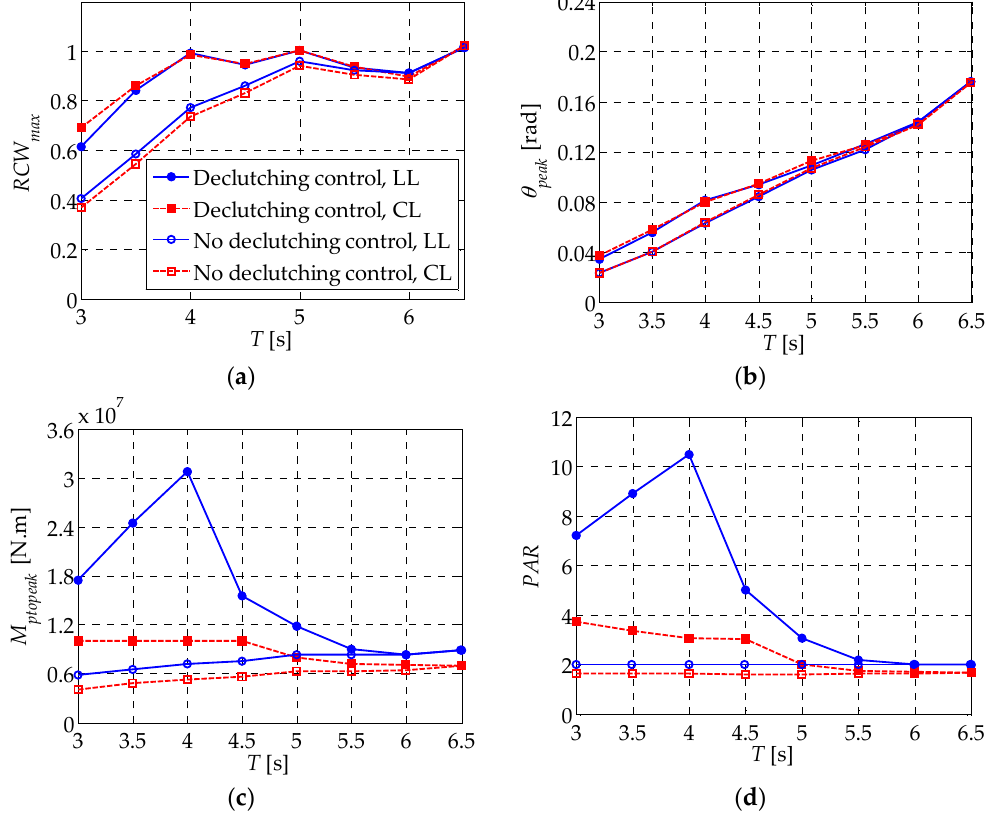
Figure 13. Duck WEC performance comparison between declutching and resistive control when relative capture width is maximized for different load types: ( a ) maximum relative capture width; ( b ) peak motion excursion; ( c ) peak PTO moment; ( d ) peak-to-average power ratio. Table 2. Magnification factor of the WEC performance under declutching control compared to that under resistive control, averaged over the wave period set T wd = {3, 3.5, 4, 4.5}. WEC Performance Parameters Linear Load Coulomb